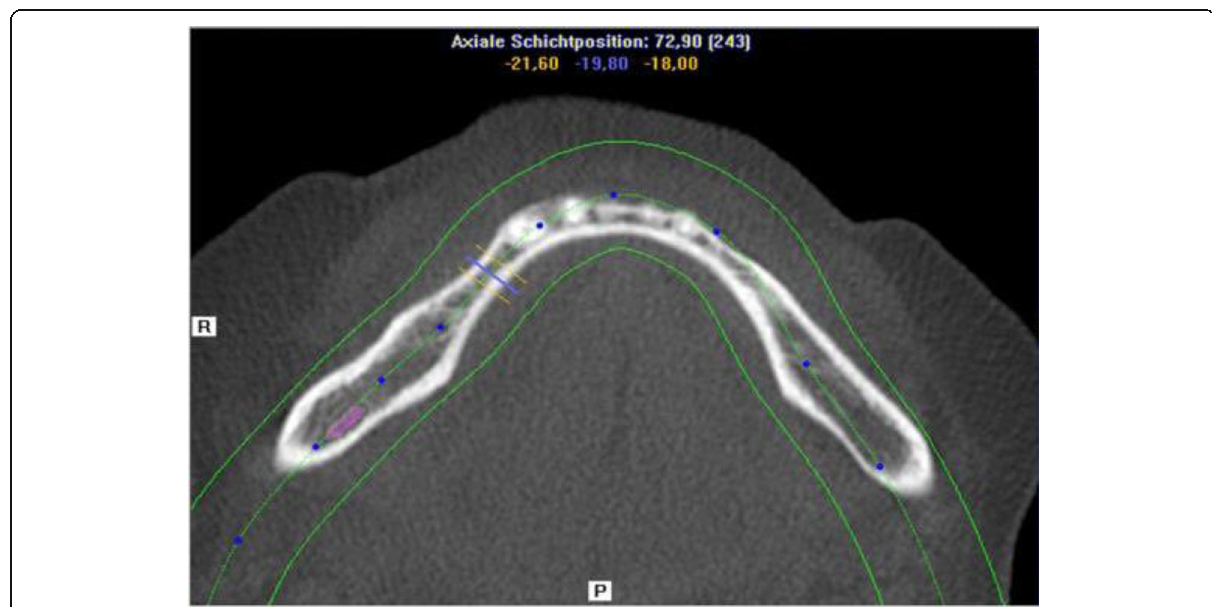
Fig. 9 Horizontal section showing bony deficit at implant